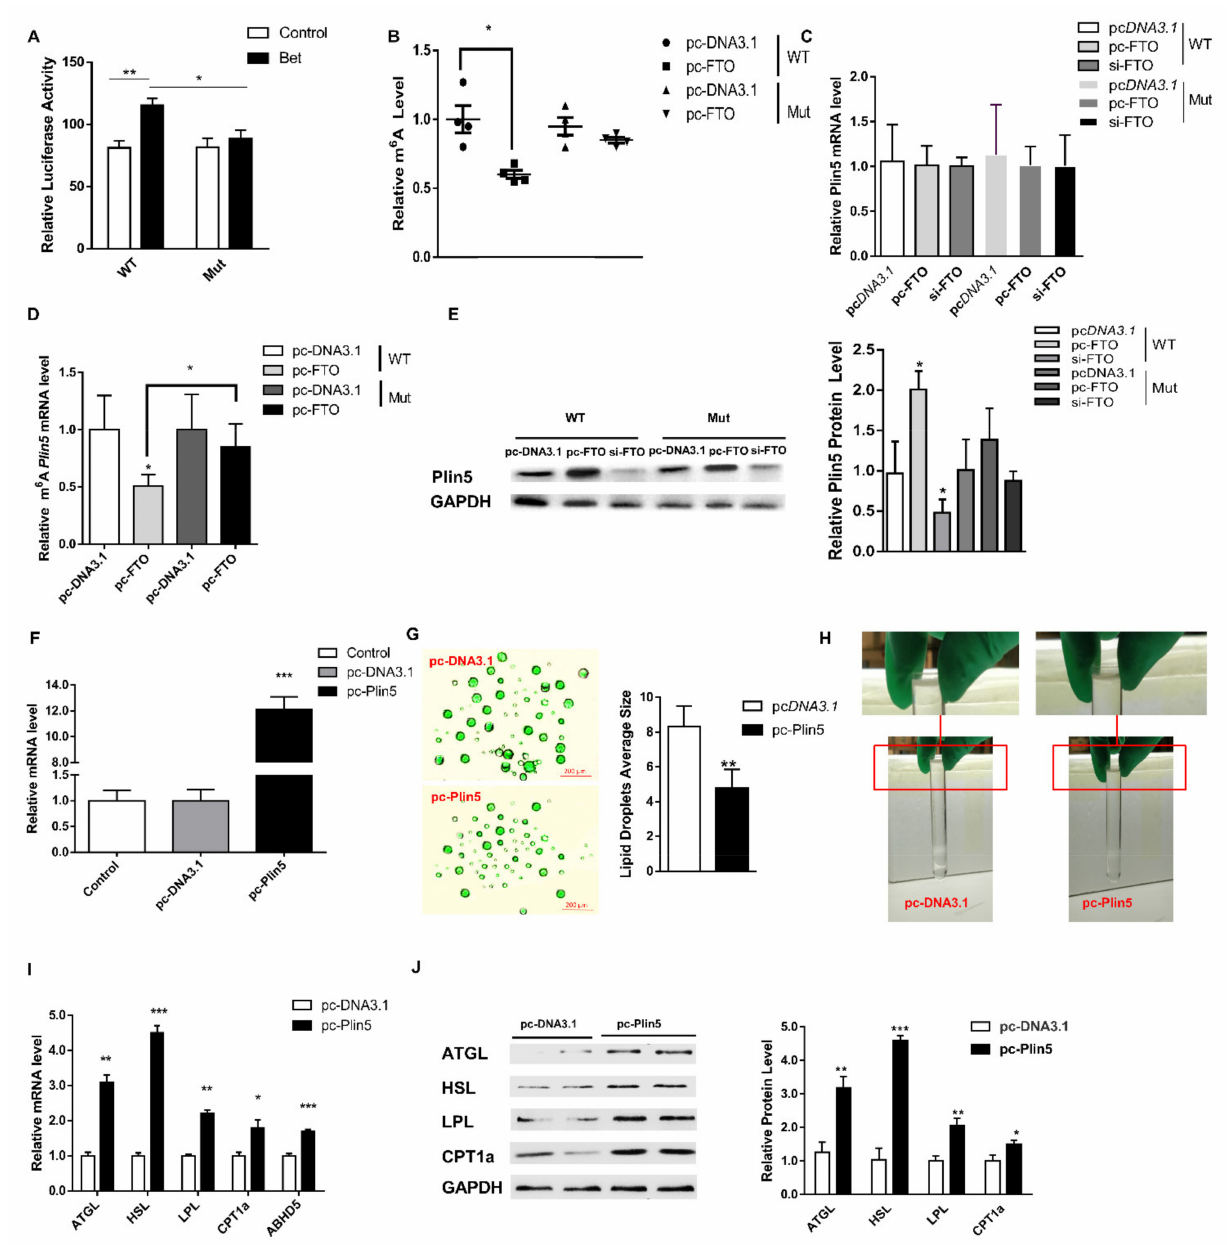
Figure 5. Plin5 regulates lipid metabolism and energy metabolism through LD. ( A ) Luciferase reporter assay was used to analyze the effect of M 6 A mutation at the 3 (cid:48) UTR end of Plin5. ( B ) Relative M 6 A level analysis of wild-type and Plin5 mutant. ( C ) Detection of Plin5 mRNA expression of wild type and Plin5 mutant type. ( D ) Plin5 m 6 A methylation analysis of wild type and Plin5 mutant. ( E ) Plin5 protein expression of wild type and Plin5 mutant type. ( F ) Real-time quantitative PCR was used to detect the efficiency of the Plin5 overexpression vector. ( G ) Porcine adipocytes in vitro were transfected with Plin5 overexpression vector and then subjected to BODIPY fluorescent staining of LD. ( H ) Observation of lipid droplet extraction. ( I , J ) Porcine adipocytes in vitro were transfected with Plin5 over-expression vector to detect lipolysis-related genes mRNA or protein levels. n = 4 for each group of cell samples, values are means ± SD. vs. control group, * p < 0.05, ** p < 0.01, *** p <